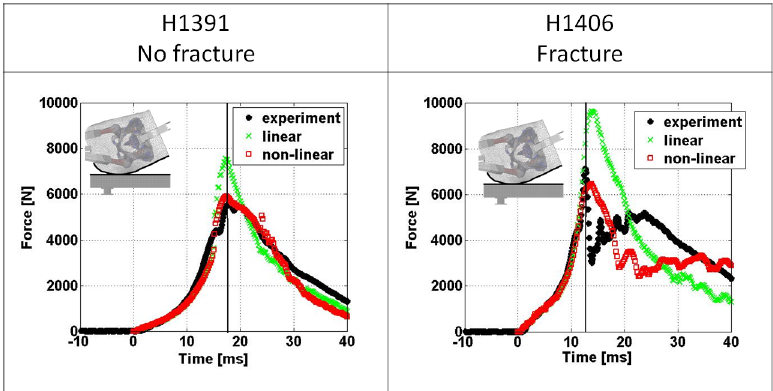
Fig 4. Comparison of impact force over time response between experimental FEM derived results. The vertical lines indicate the time of experimentally measured peak impact force.